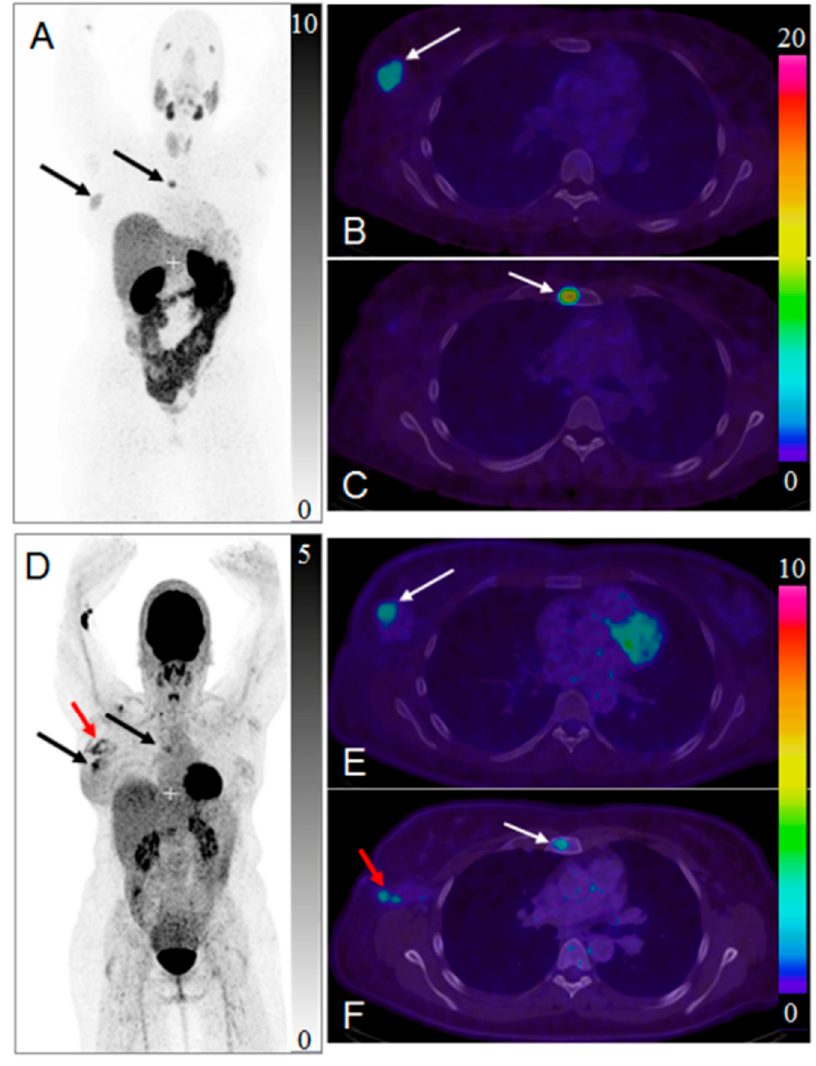
Figure 12. Maximum intensity projection positron emission tomography (PET) images of whole-body scan with [ 68 Ga]Ga-ABY-025 (( A ) 2 h) and [ 18 F]FDG ( D ). Transaxial PET-CT fused images of the primary tumor (( B , E ), respectively for [ 68 Ga]Ga-ABY-025 (2 h) and [ 18 F]FDG) and metastasis (( C , F ), respectively for [ 68 Ga]Ga-ABY-025 (2 h) and [ 18 F]FDG). The black and white arrows indicate known tumor deposits. The red arrow ( D , F ) indicate post-surgical inflammation after biopsy wherein sentinel lymph node was tumor- and HER2-negative. Reproduced from [184].